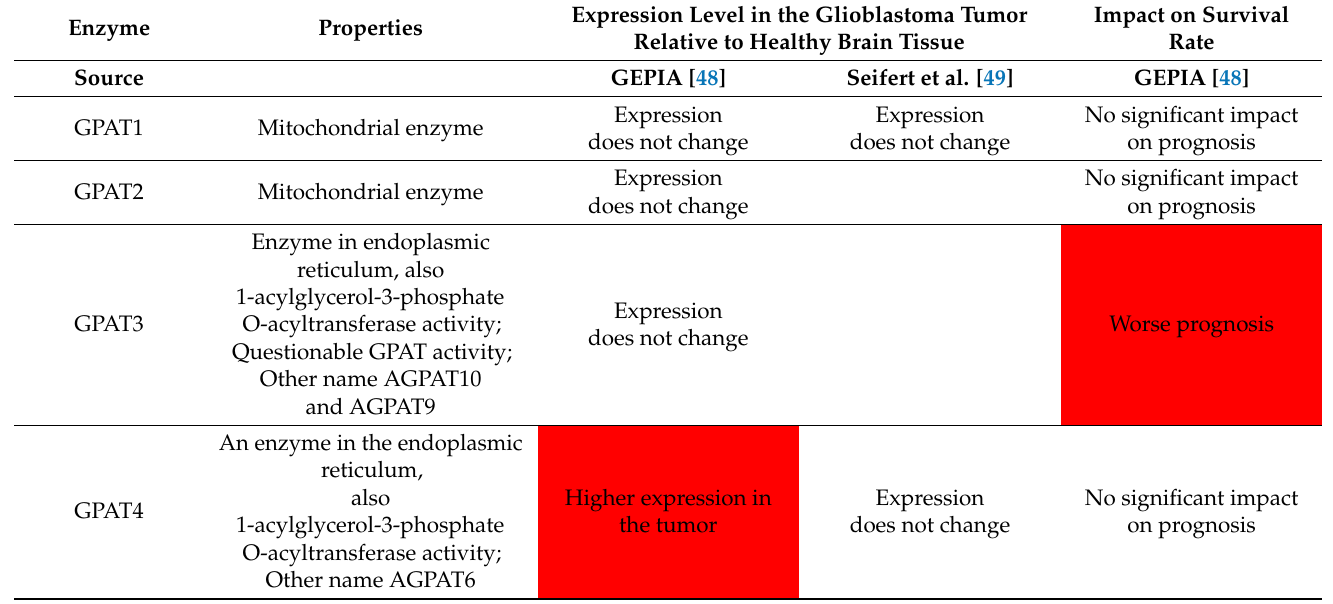
Table 4. Characteristics of GPAT, enzymes involved in the biosynthesis of lysophosphatidic acid from